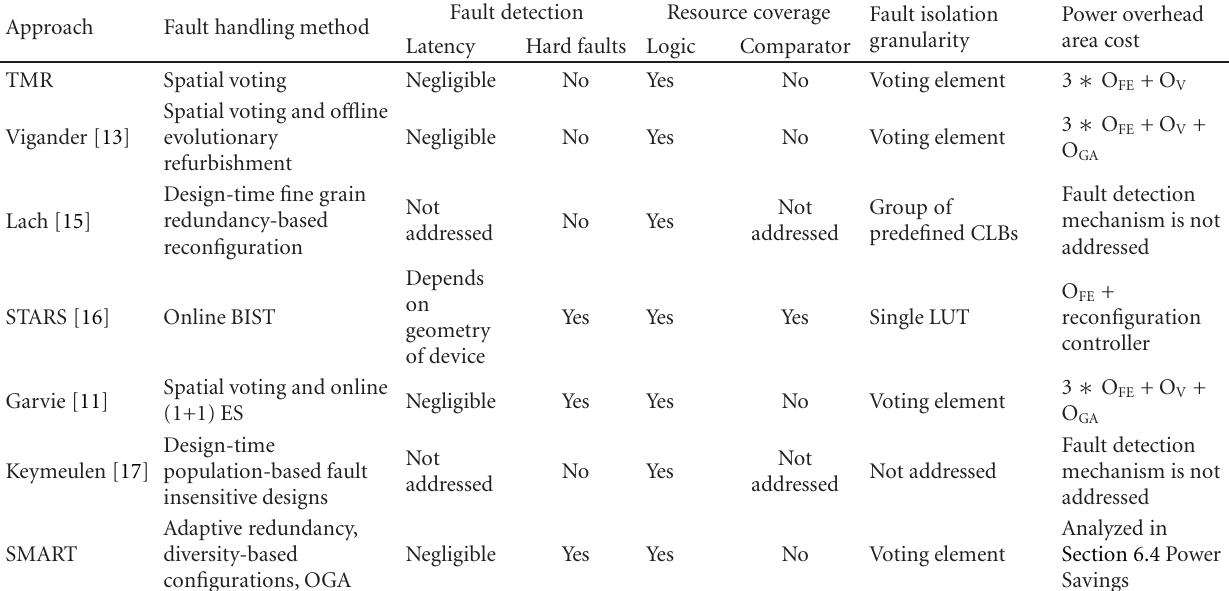
Table 1: Comparison between SMART and other prominent fault-tolerance